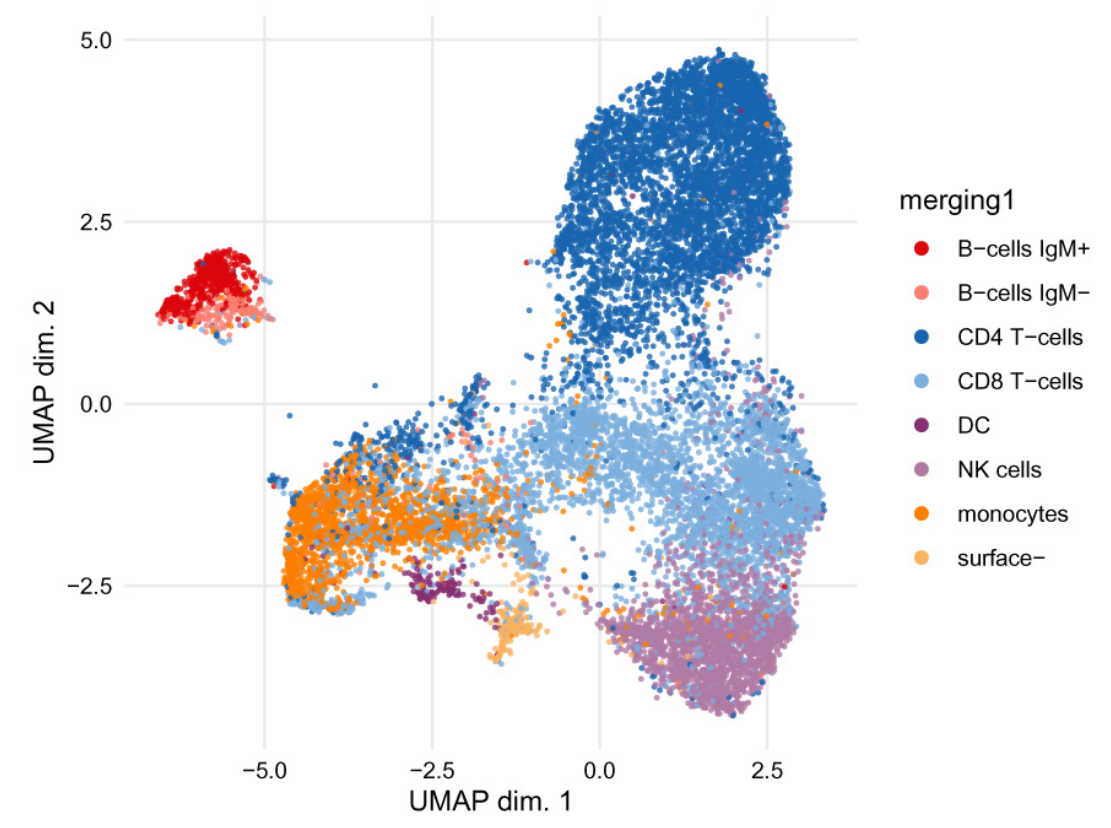
Figure 15. UMAP plot for the PBMC dataset, where cells are colored according to the manual merging of the 20 cell populations, obtained with FlowSOM, into 8 PBMC populations. As in Figure 10, UMAP uses the arcsinh- transformed expression of the 10 lineage markers in 1000 randomly selected cells from each of the 16 samples.